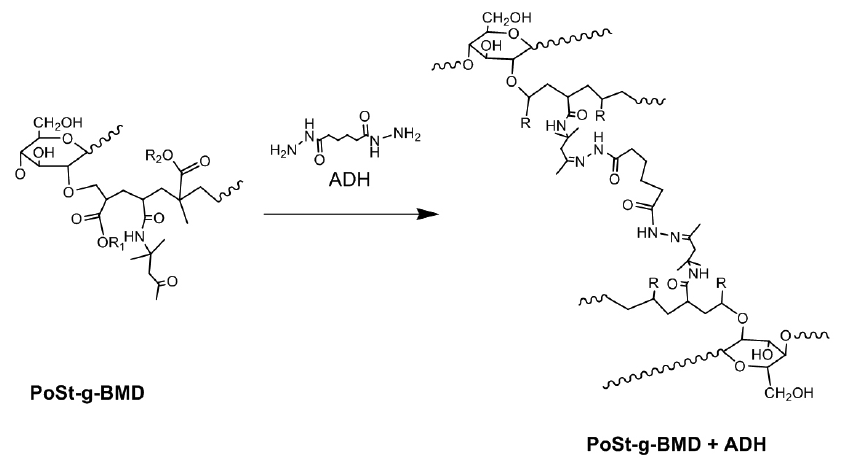
Figure 2. Cross-linking reaction of PoSt-g-BMD with